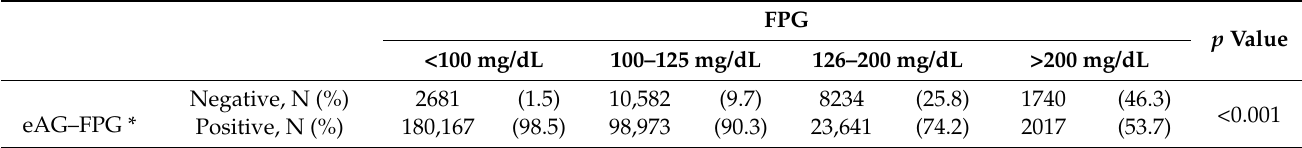
Table 3. Differences between eAG and FPG in the study subjects.